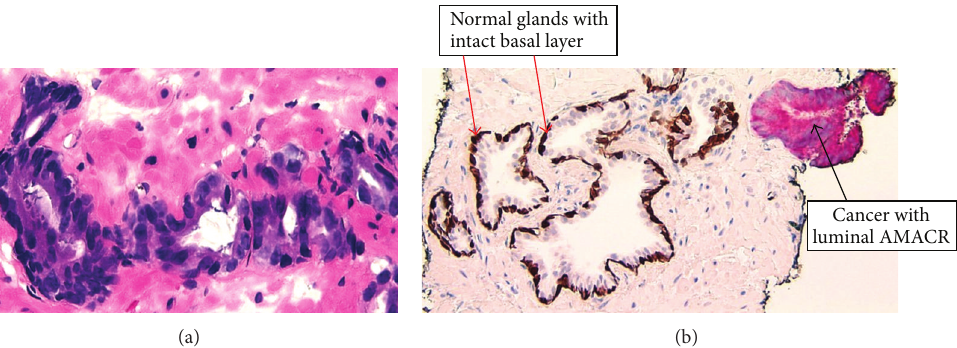
Figure 1: (a) Prostate adenocarcinoma Gleason grade 6 (3 + 3), 20x hematoxylin and eosin. (b) Normal glands have intact basal layer stained dark brown with CK 5/6. Cancer tissue lacks basal layer and luminal glands show finely granular pink cytoplasmic stain, 20x PIN4 cocktail.